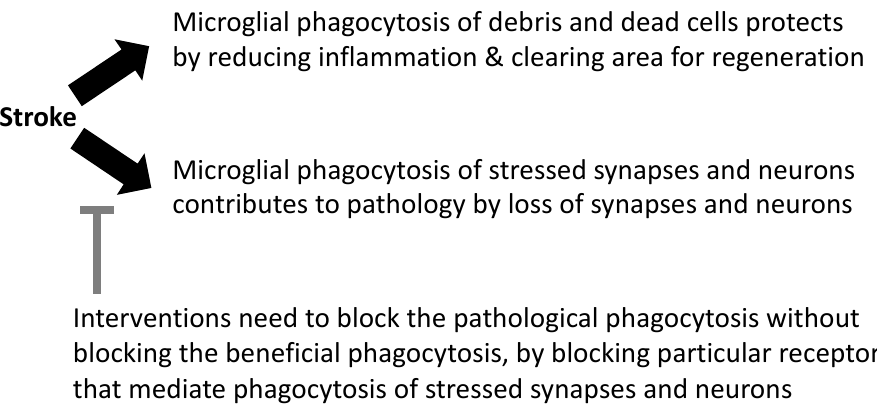
Figure 3. The divergent roles of microglial phagocytosis in stroke pathology. Potential targets to reduce delayed neuronal loss after stroke include: TMEM16F, which mediates the phosphatidylserine exposure and subsequent phagocytosis after stroke [45], and complement activation and subsequent phagocytosis via complement receptor 3 [55,60–62]. The C3a receptor [41,42,60] and the P2Y 12 receptor [36], which both mediate microglial recruitment, are also potentially attractive targets to prevent neuronal loss after stroke. Blocking the phagocytic receptors MerTK and the vitronectin receptors (integrins α v β 3 or α v β 5 ) can also prevent the phagocytosis of stressed neurons in stroke models [23,43]. Recently it was shown that the knockout of the phagocytic receptor MerTK, specifically in microglia and macrophages, reduced synaptic loss, brain atrophy and neurological deficits in mouse models of both ischemic and hemorrhagic stroke, whereas the knockout of the phagocytic receptor MEGF10, specifically in astrocytes, reduced synaptic loss and brain atrophy only in the ischemic model of stroke [65]. The latter finding suggests that phagocytosis by both microglia and astrocytes can be detrimental in ischemic stroke. The phagocytic vitronectin receptor ( α v β 3 ) can be blocked with RGD-containing peptides, and the nasal delivery of these peptides provides substantial protection in rat models of ischemic stroke [66,87]. Hence, more research and clinical trials targeting microglial phagocytosis are likely to be of benefit in stroke medicine.